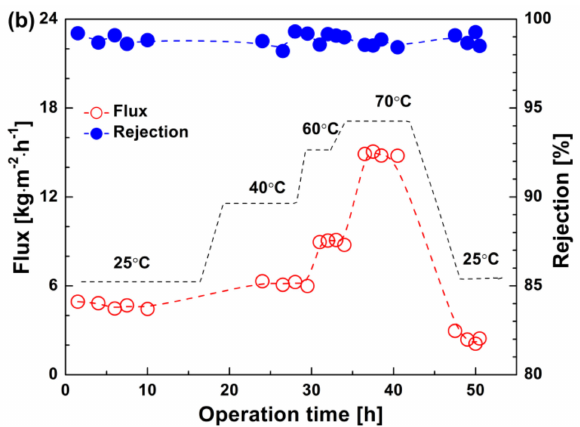
Figure 6. Water flux and NaCl rejection of the BTESE-200 membrane as a function of ( a ) concentration cycles and ( b ) temperature cycles.